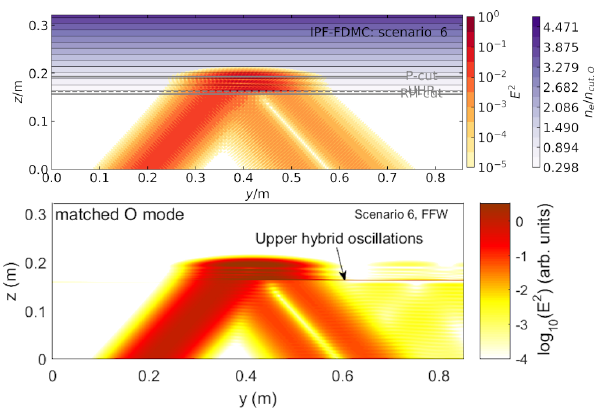
Figure 6. Di ff erence of the detector antenna signals obtained from the full-wave simulations for scenario #4.